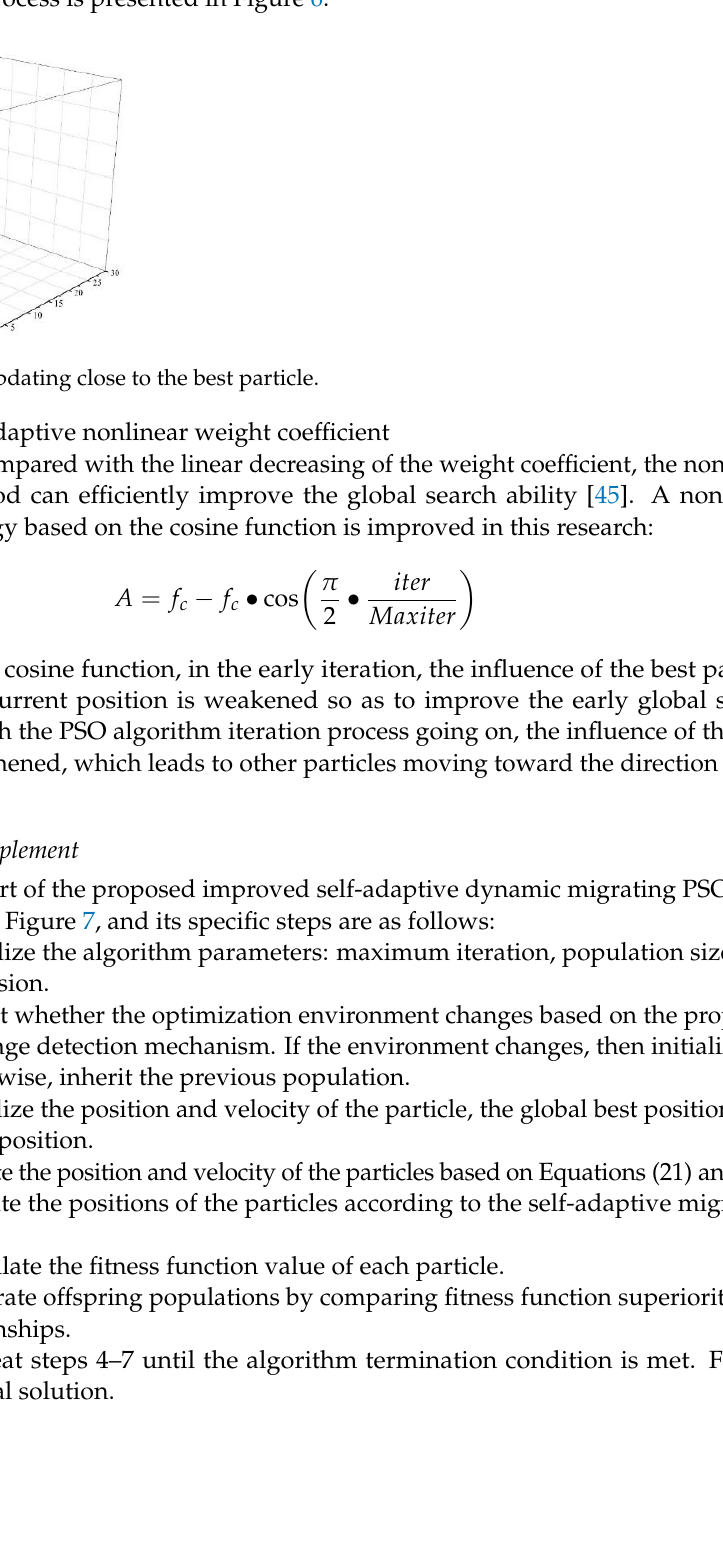
Figure 5. Wolves moving toward the direction of the best particle.